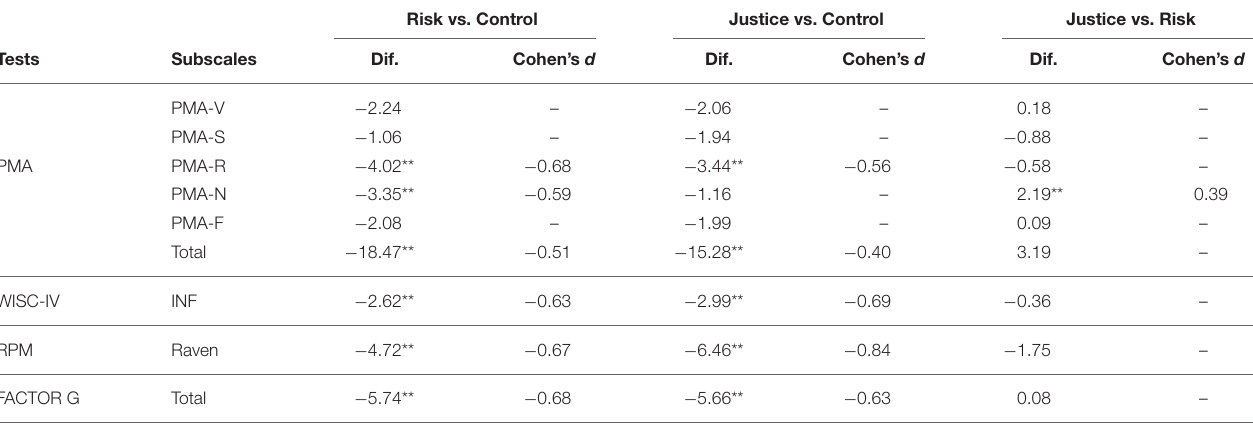
TABLE 5 | Pairwise comparisons for the intelligence measures.